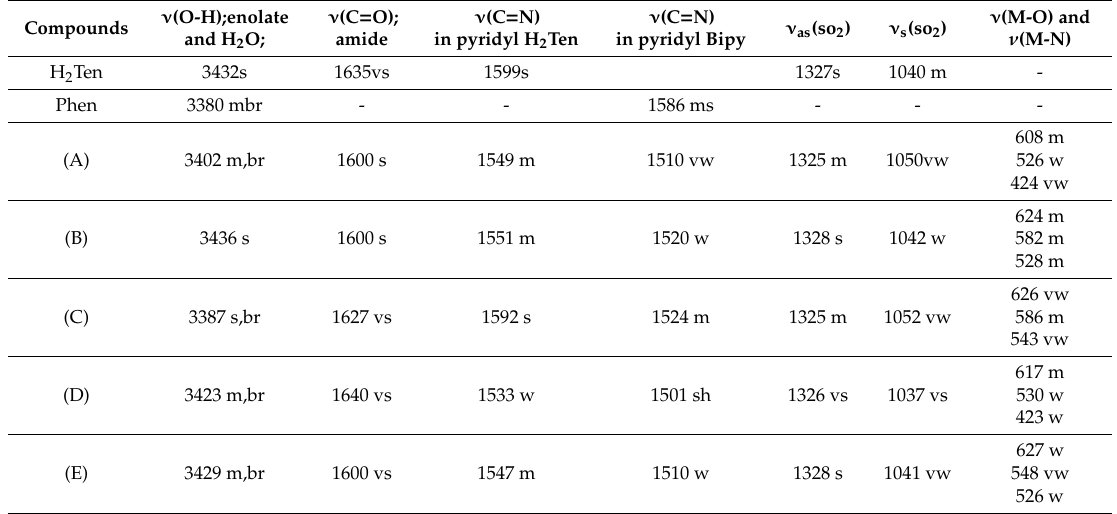
Table 1. Selected infrared wave numbers (cm − 1 ) for H 2 Ten, Phen and their metal complexes